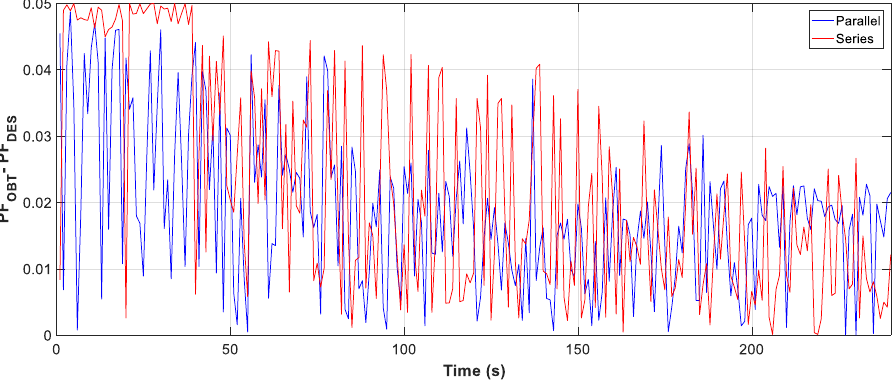
ff erence between PF Figure 19. Difference between PF OBT and PF DES . Figure 19. Di OBT and PF DES Figure 19. Difference between PF OBT and PF DES .